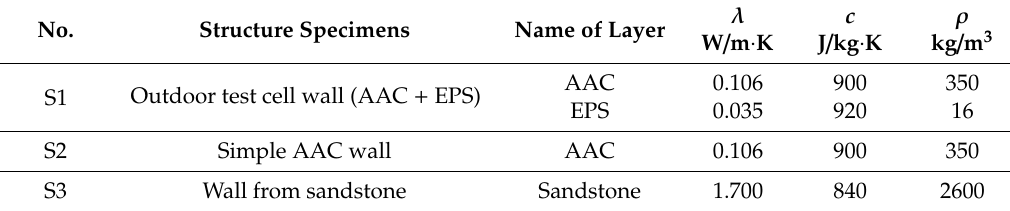
Figure 7. The measured temperature values of the interior and exterior surfaces for the analyzed interval (14 February, 2015 to 19 February, 2015). 3. Results and Discussion 3.1. Numerical Experiment Results Figures 8 and 10 show the temperature balancing phenomenon due to a different thermal diffusivity (2) of the simple sandstone and AAC walls. The results of temperature represented by its courses, calculated in the test case using simple boundary conditions, consider various initial conditions. The boundary condition of exterior temperature for the calculation in this case is the sinusoidal function ( θ e , as shown in Figure 6). The boundary condition of interior temperature is a constant value of 20° over the presented time period ( θ i ). Figure 9 shows sandstone; Figure 11 shows AAC; and Figure 14 shows AAC + EPS-simulated temperature profiles, after 0, 12 and 24 h. Temperature profiles are plotted to show their compliance with different IC considerations. The temperature buffering time over the structure is extended when the thermal transmittance is decreased (application of external thermal insulation composite system, ETICS). When AAC with ETICS is used, temperature buffering takes five days or more (Figures 12 and 13). If the temperature course analysis in the structures has short time intervals, the correct initial condition is highly recommended and relevant.